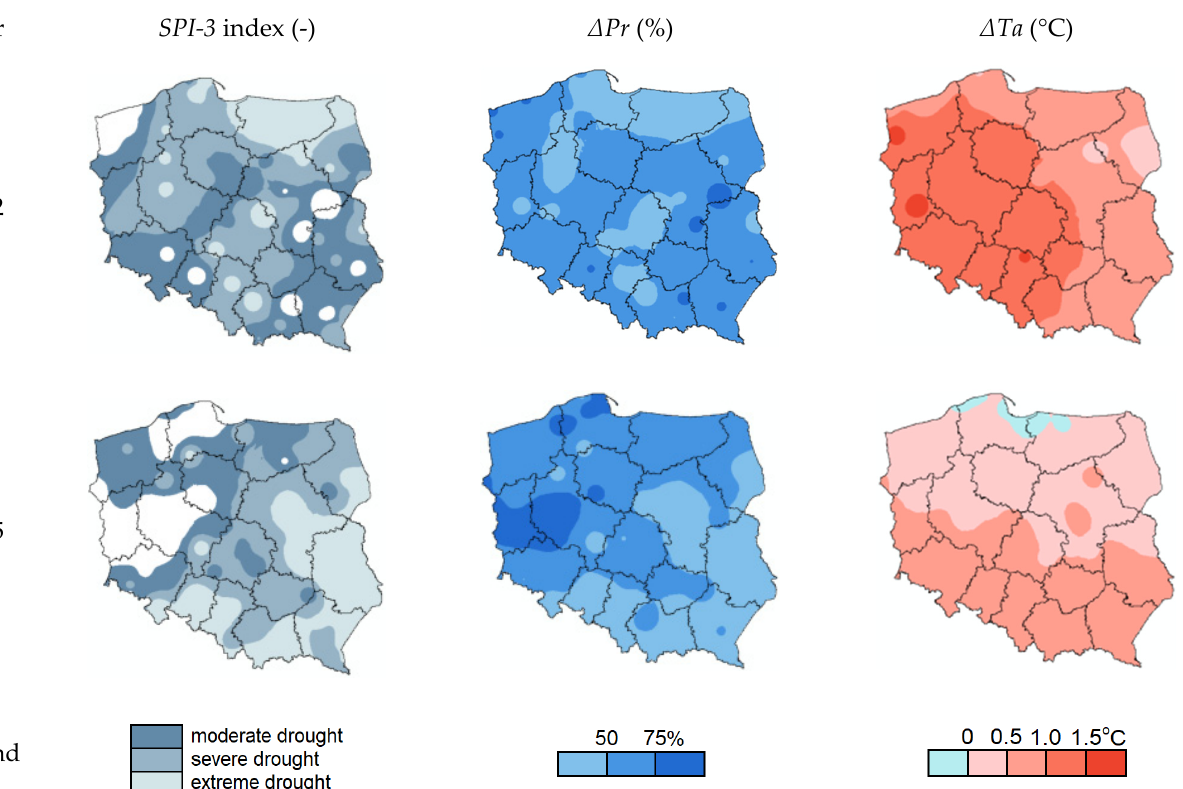
Figure 4. Spatial distribution of SPI-3 , Δ Pr and Δ Ta in Poland in summer in years when the SPI-3 value for a given area was ≤− 2 (1992, 2015). Notes as in Figure 3.